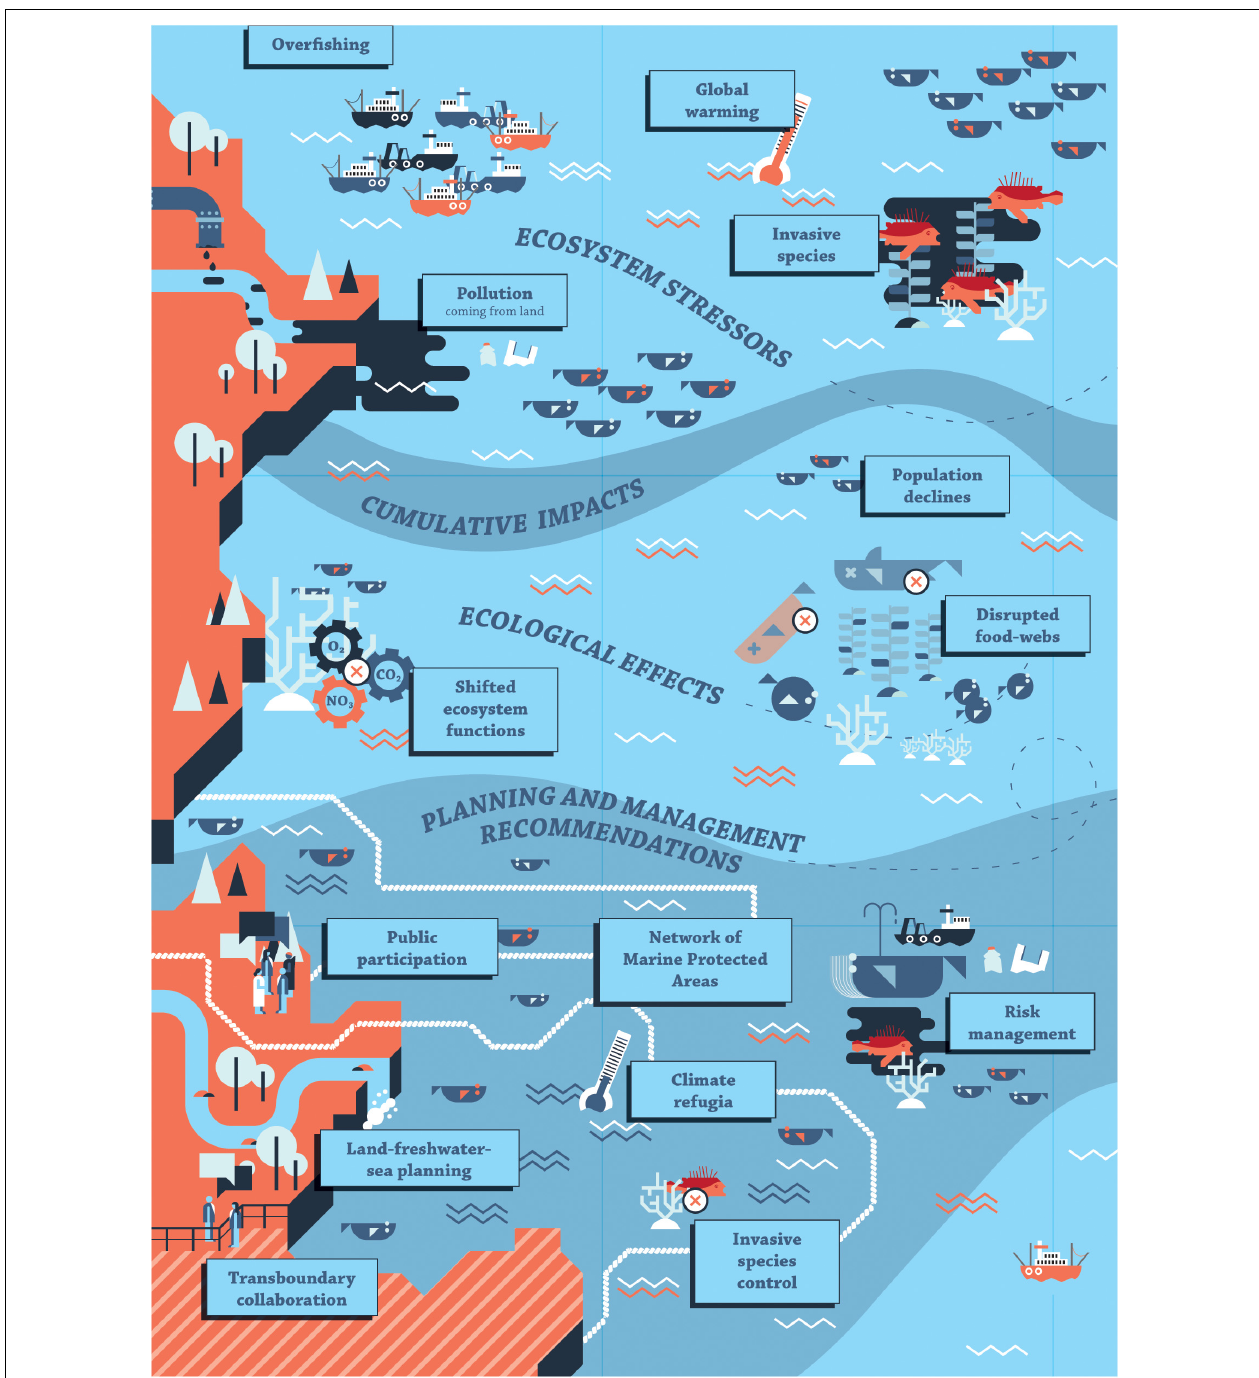
FIGURE 1 | Infographic showing the challenges MarCons aimed to address through planning and management